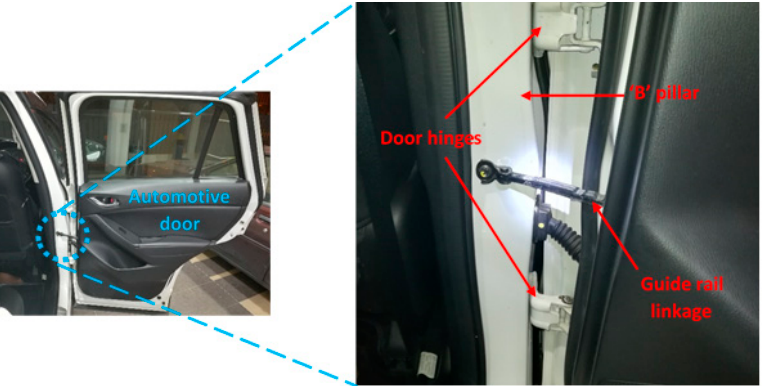
Figure 16. A typical linkage working operation of an automotive vehicle model: Mazda CX-5